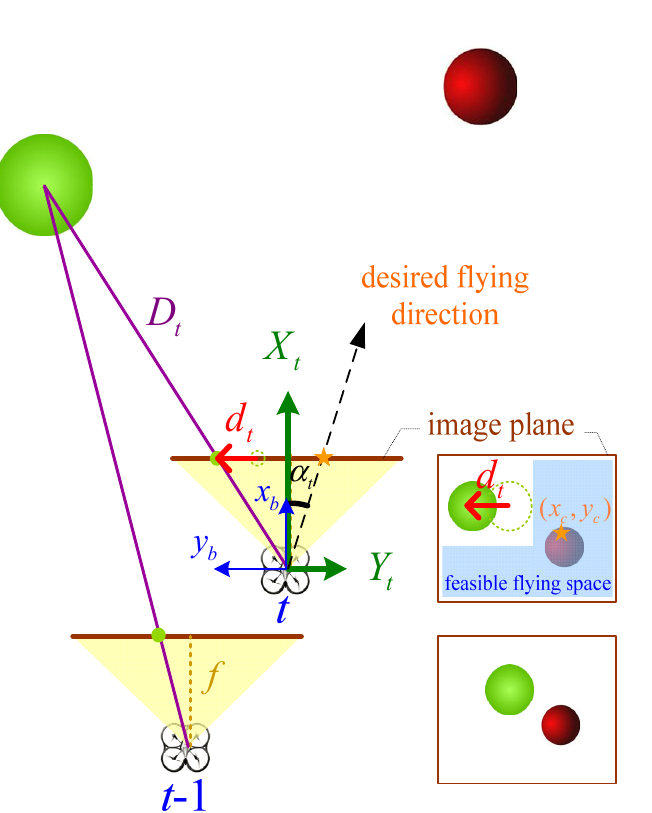
Figure 7. The MUAV flies toward the desired flying direction on image plane.